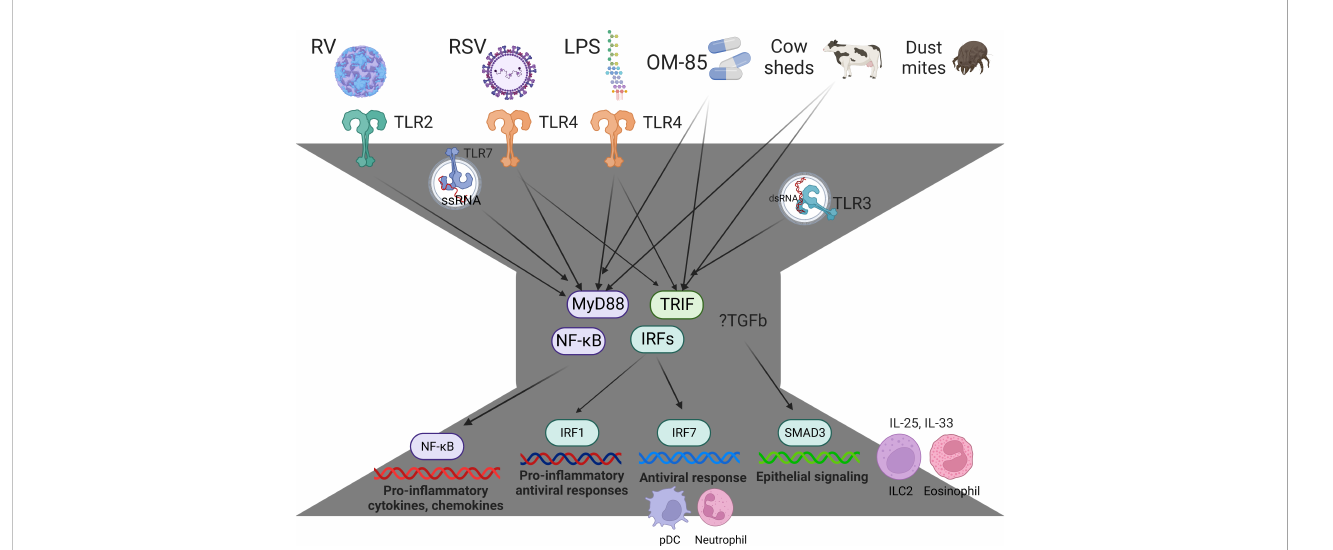
FIGURE 1 Innate immune responses and immune training are governed by a bow-tie architecture. The bow-tie is a three-layered ordered control system comprising an input layer, a core, and an output layer. The input layer is comprised of pathogen-recognition receptors (e.g. TLR2, TLR3, TLR4, TLR7, MDA5, RIGI), and this layer acts as a sensor for exposure to a broad range of conserved molecular structures derived from viruses, bacteria, allergens, and cow sheds. The core consists of essential, non-redundant components that act as signal integrators or transmitters, such as Myd88, TRIF, and members of the NF k B and IRF family of transcription factors. The output layer consists of a suite of proin fl ammatory cytokines, chemokines, and antiviral proteins, which mediate immune effector functions. The core components Myd88/TRIF are essential for innate immunity, and these pathways mediate the protective effects of Amish house dust and OM-85 (46, 47). With regards to the output layer, NF k B mediates proin fl ammatory responses (e.g. IL-1b, IL-6, IL-8, Tnf), IRF7 mediates antiviral responses (e.g. Mx1, ISG20, OASL, RSAD2 (39)) and IRF1 mediates proin fl ammatory antiviral responses (CXCL9, CXCL10, CXCL11 (48)). RV-induced exacerbations are associated with upregulation of SMAD3 signaling and exaggerated IL-25 and IL-33 responses (40, 45, 49, 50). IRF7hi responders rapidly mobilize pDC into the response and operate through a lung-blood-bone marrow axis (43). IRF7lo responders